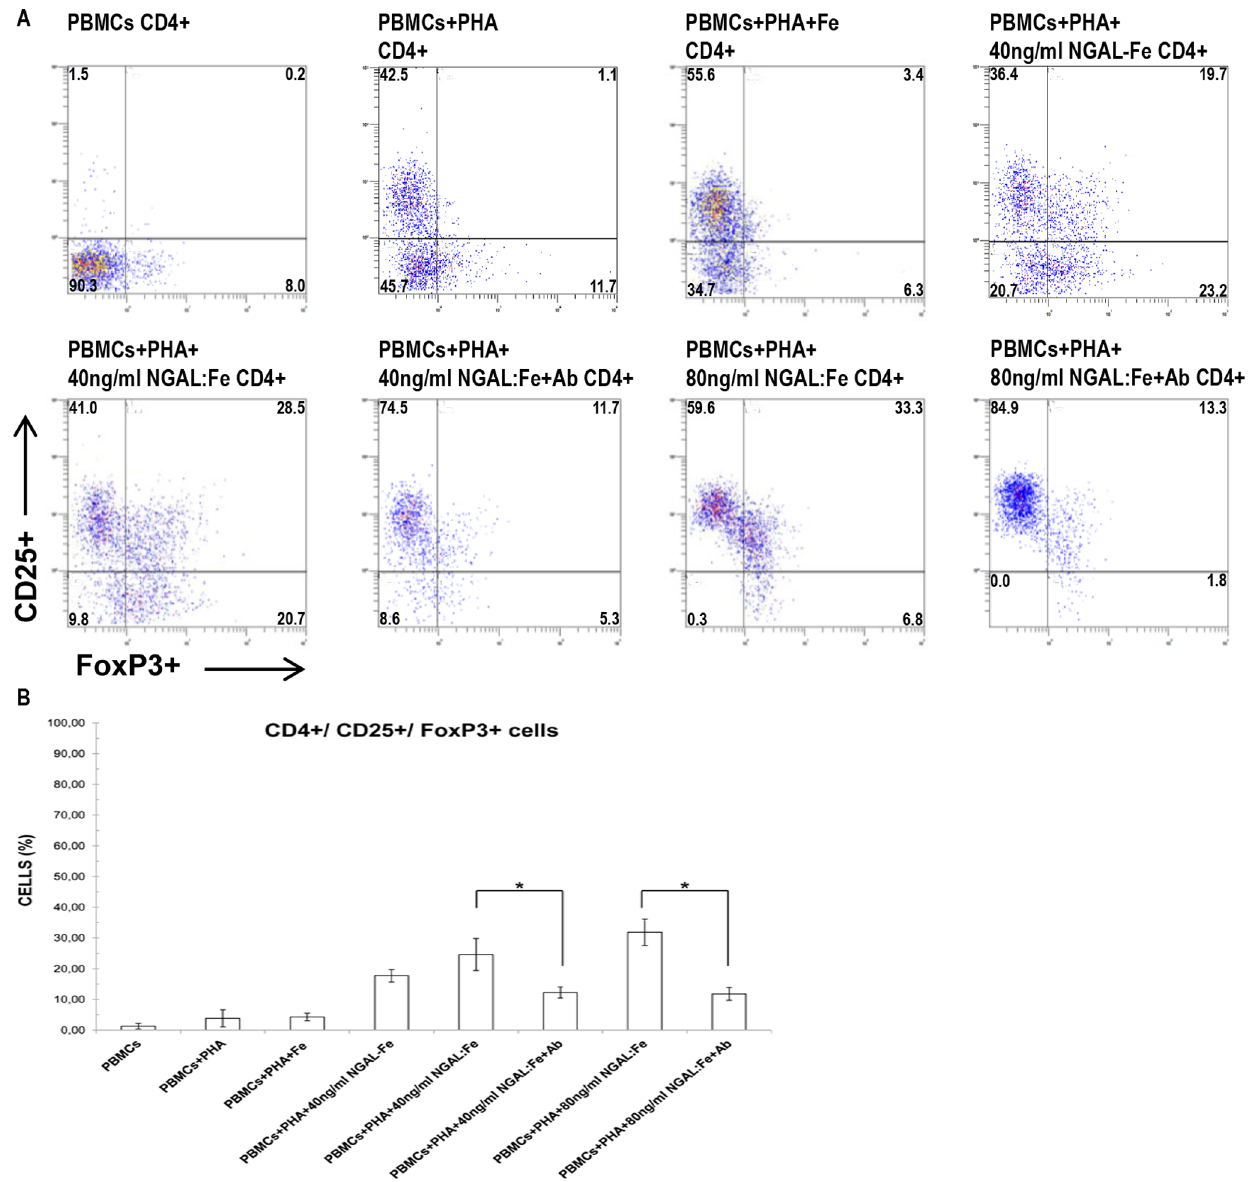
Figure 4. Effects of iron and NGAL neutralization on the percentage of CD4 + /CD25 + /FoxP3 + cell population. Flow cytometry analysis of CD25 + /FoxP3 + expression on CD4 + cells in PHA-activated PBMCs. Iron treatment (without NGAL) did not increase the percentage of CD25 + /FoxP3 + cells. Treatment with NGAL:enterobactin complex (without iron) reduced the percentage of CD25 + /FoxP3 + cells in contrast to stimulation with NGAL:Enterobactin:Iron. Incubation with anti-NGAL antibody reduced the percentage of CD25 + /FoxP3 + cells. Data are representative of 8 independent experiments. The number in each quadrant represents the percentage of CD25 + foxP3 cells on gated CD4 + cells of the total population. B) Data are expressed as percentages of CD4 + /CD25 + /FoxP3 + cells. Means 6 SD; n=8. * p ,